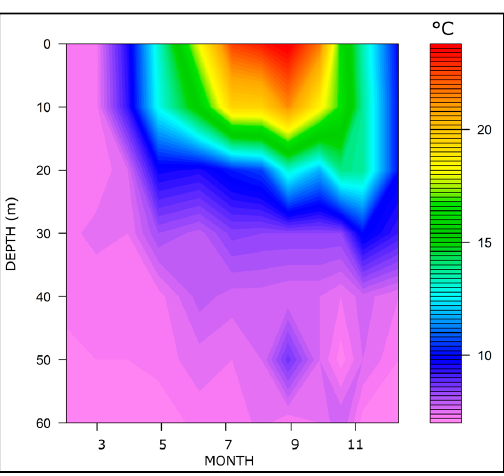
Figure 2. Heatmap of water temperature in Lake Iseo from January to December 2016.